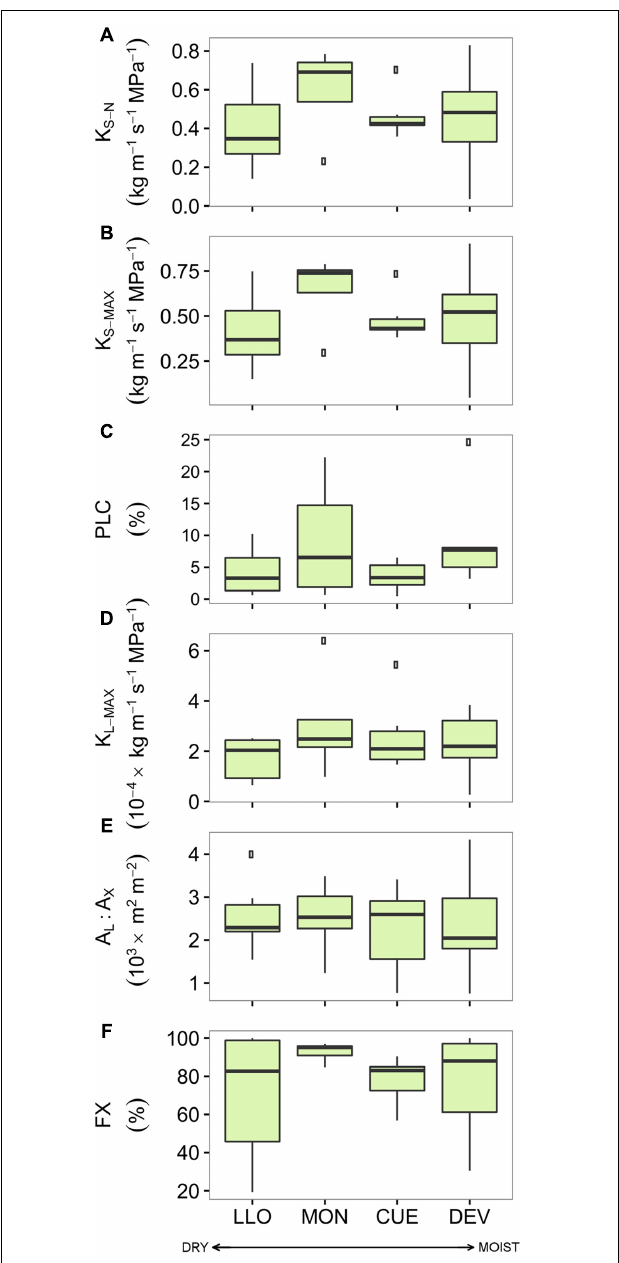
FIGURE 3 | Hydraulic traits of the four Scots pine populations sampled across an aridity gradient: (A) xylem-specific native hydraulic conductivity, (B) xylem-specific maximum hydraulic conductivity, (C) native percentage of loss hydraulic conductivity, (D) leaf-specific maximum hydraulic conductivity, (E) leaf-to-xylem area ratio, and (F) functional xylem fraction. Sites are ordered respect to P/PET annual (see Table 1 ). Boxes represent 50% of the data (between the first and third quartiles). Median is shown as horizontal line. Bars extend from the box to the highest/lowest value within 1.5 ∗ inter-quartile range (IQR). Points (outliers) are values > 1.5 ∗ IQR. Note: None of the differences among sites was significant (see Supplementary Table S3). K S - N , xylem-specific native hydraulic conductivity; PLC, native percentage of loss hydraulic conductivity; K S - MAX , xylem-specific maximum hydraulic conductivity; K L - MAX , leaf-specific maximum hydraulic conductivity; A L : A X , leaf-to-xylem area ratio; FX, functional xylem